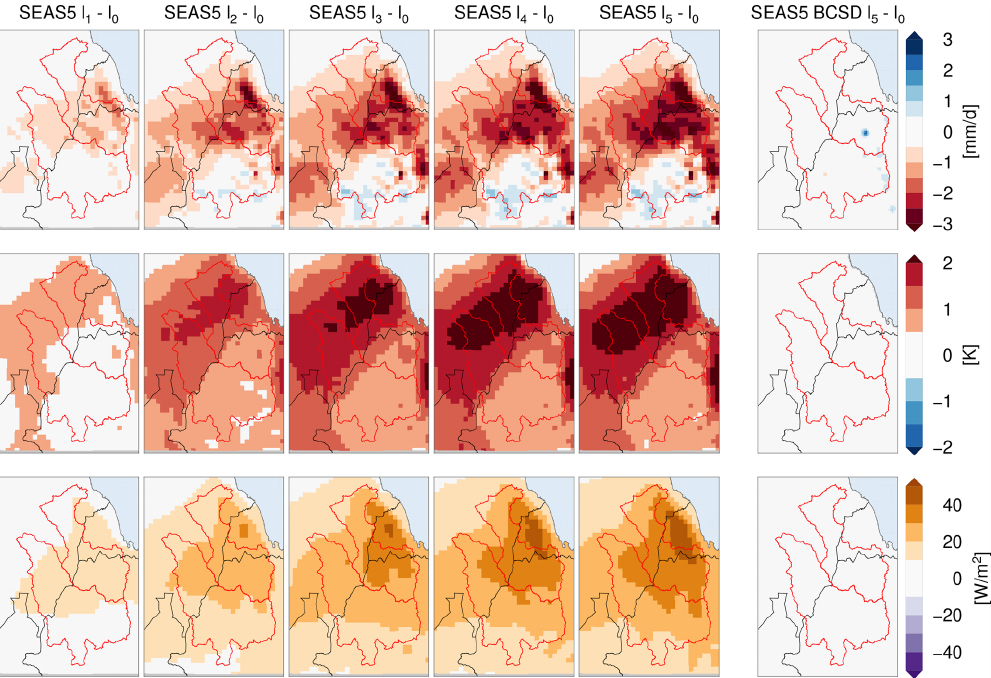
Figure 5. Differences between the July forecasts from different issue months for precipitation (top row), temperature (middle row) and radiation (bottom row) for the African Domain